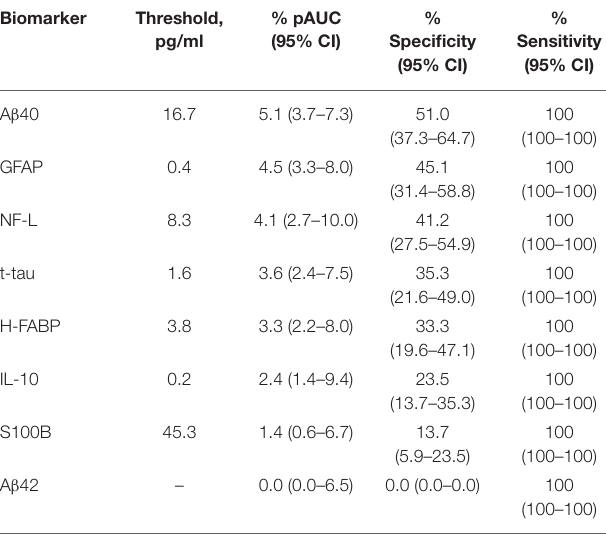
TABLE 5B | Abilities of the Helsinki Computed Tomography Score alone and a panel consisting of the Helsinki Computed Tomography, interleukin 10, and β -Amyloid isoform 1–40 in distinguishing patients with unfavorable outcome from patients with favorable outcome.